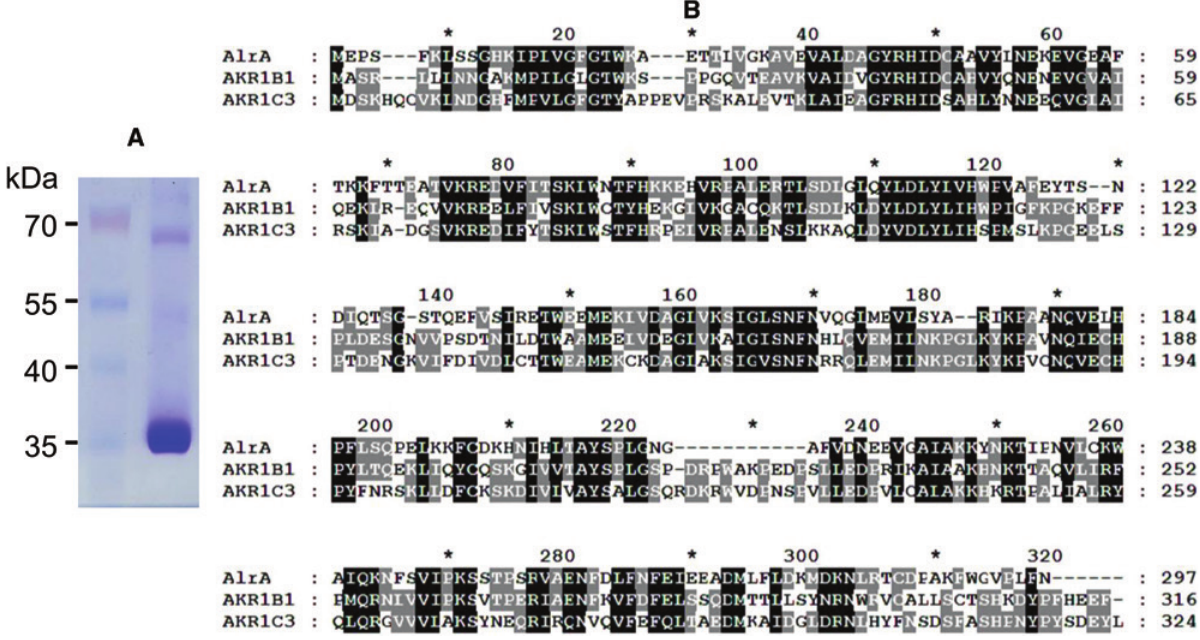
Figure 3: SDS-PAGE of the purified AlrA and its homology to human AKRs. (A) The final purified fraction was analyzed by a SDS-PAGE of 10% polyacrylamide under reducing condition. The molecular masses of the marker proteins are shown on the left. The protein having an apparent molecular mass of 35 kDa was subjected to mass spectrometry. (B) Multiple alignment of protein sequences. Conserved sequences are shaded at four levels using GeneDoc software.